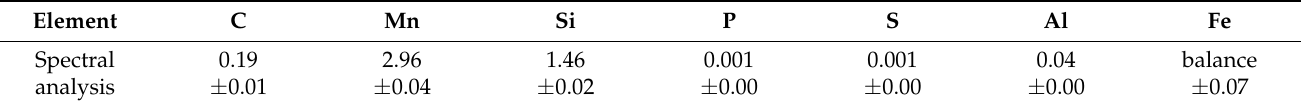
Table 1. Chemical composition of the investigated lean medium Mn Q&P steel